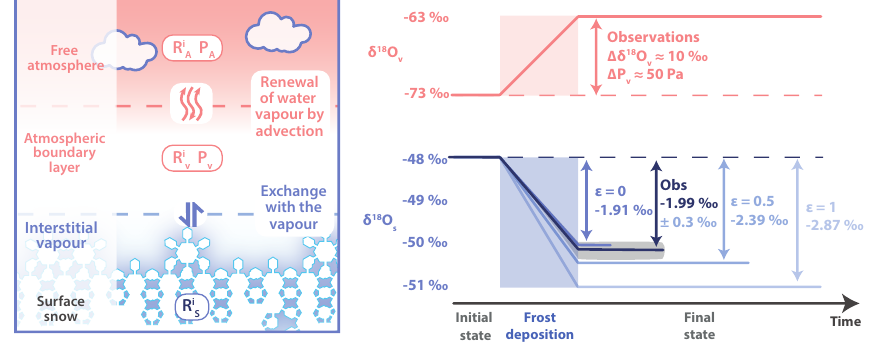
Figure 6. Schematic of the thermodynamic model to visualise exchanges between snow and vapour during condensation: the snow exchange with the vapour through equilibrium fractionation at the phase transition and the atmospheric vapour in the atmospheric boundary layer is only weakly renewed by advection of air masses (0%: no advection, closed box system in blue; 50%: the contribution of the advection is equal to half the amount of water vapour involved in the phase transition (purple); 100%: in